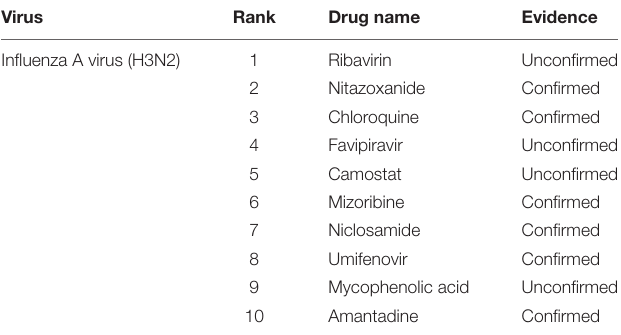
TABLE 2 | Top 10 possible drugs against influenza A virus (H3N2) predicted by DRMMN. Virus Rank Drug name